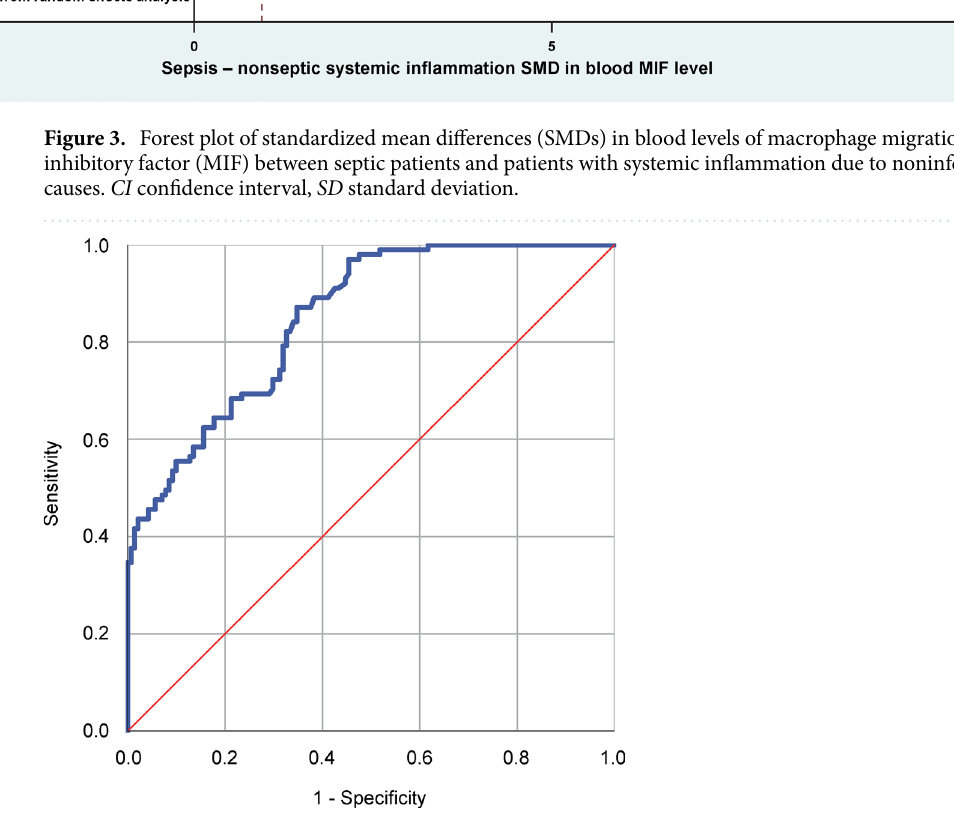
Figure 4. Receiver operating characteristic (ROC) curve analysis of the diagnostic performance of blood macrophage migration inhibitory factor (MIF) levels in sepsis. The individual data of septic patients (N = 101) and healthy controls (N = 141) were extracted from previously published studies 25–27 . The area under the blue ROC curve was 0.850. The diagonal red line serves as a reference line corresponding to the ROC curve of a diagnostic test that randomly classifies the condition (i.e., a test that has no diagnostic